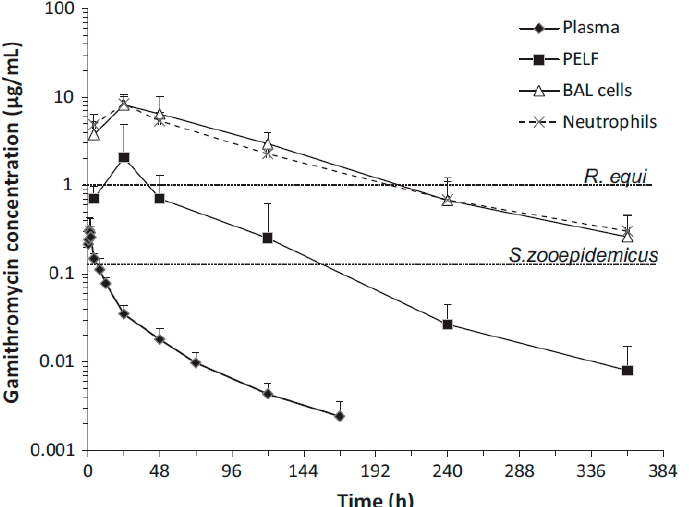
Figure 4. Gamithromycin concentrations in plasma, BAL cells, PELF, and neutrophils of 6 foals following a single IM dose of gamithromycin (6 mg/kg). The dotted horizontal lines represent the MIC 90 of Rhodococcus equi (1 µg/mL) and Streptococcus zooepidemicus (0.125 µg/mL) isolates [47]. Copyright © 2012 John Wiley & Sons, Inc.